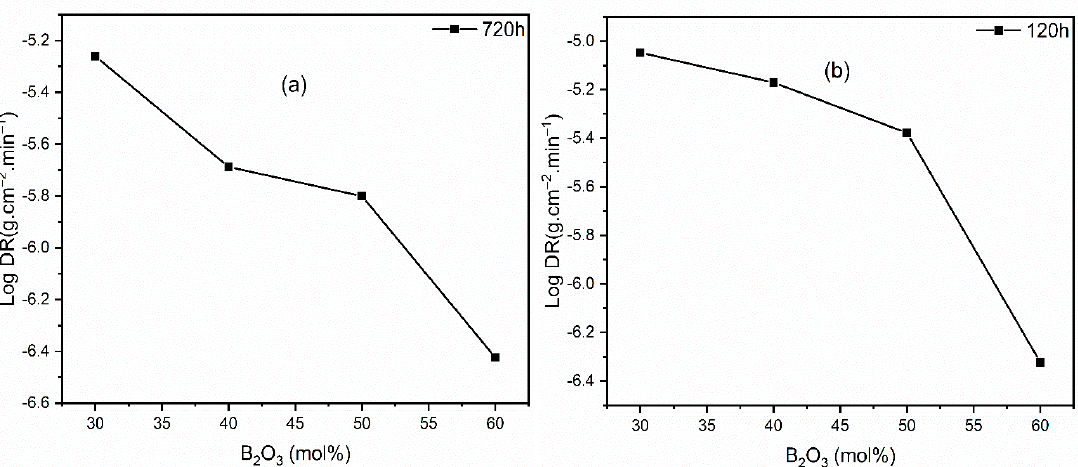
Figure 3. Changes in the dissolution rate (DR) versus the composition of 40 CaO-(60 − x) B 2 O 3 -x V 2 O 5 glasses (x = 0, 10, 20, and 30 mol%) after immersion in deionized water ( a ) and in HCl solution ( b ).